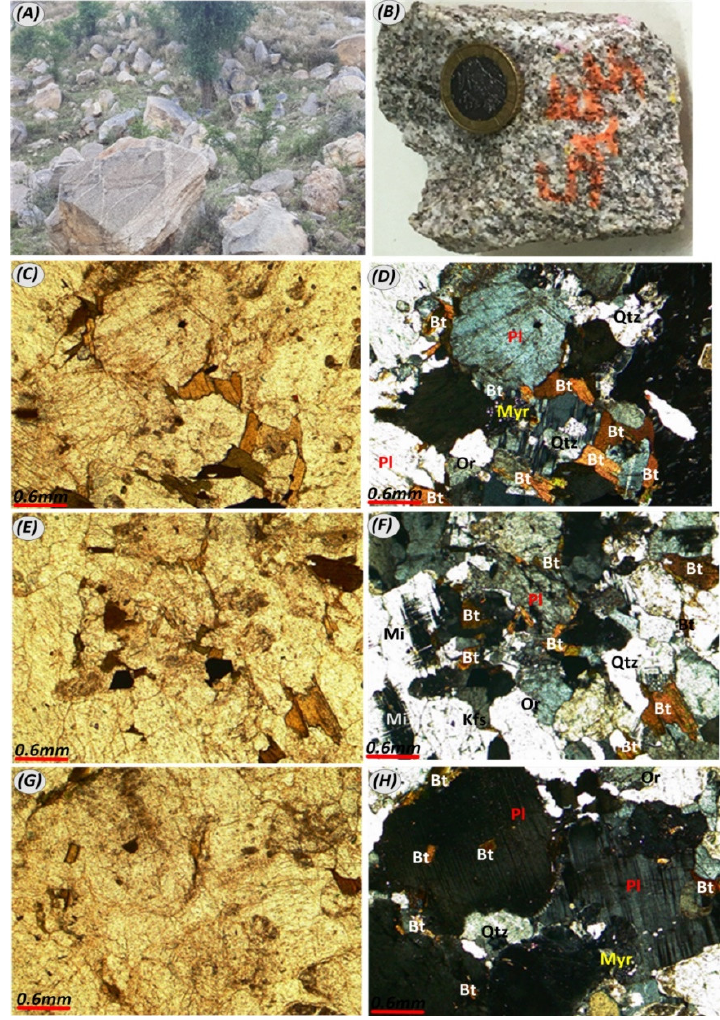
Geosciences 2022 , 12 , x FOR PEER REVIEW 6 of 10 Figure 4. Oyo massif ( A ) outcropping conditions (field of view is 10 m wide); ( B ) hand sample with 2 cm coin; ( C – H ) thin slide optical microscope views alternatively without or with crossed nicols ( left and right ) with phase identification indicated (quartz = Qtz, orthose = Or or Kfs, plagioclase = Pl, biotite = Bt, myrmekite intergrowth of quartz and plagioclase = Myr or Mi).